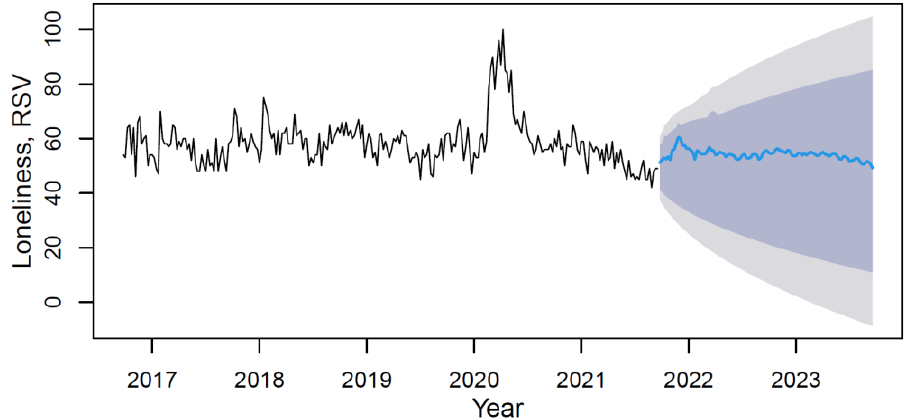
Figure 6. The l oneliness’s data time series plot (solid black line) with forecast (solid blue line) on light grey (95% CI) and dark grey (80% CI) backgrounds by applying the M3 hybrid model.